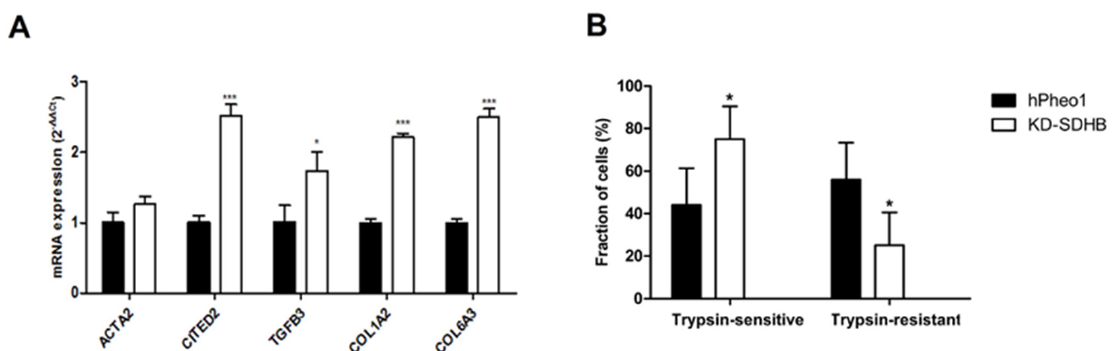
Figure 3. ( A ) Cell adhesion related genes upregulated by KD-SDHB. Relative mRNA expression of ACTA2 , CITED2 , TGFB3 , COL1A2 , and COL6A3 in KD-SDHB hPheo1 cells by RT-qPCR analysis. ( B ) Cell counts for trypsin-sensitive and trypsin-resistant hPheo1 cells presented as percentages of total cell number. Each bar represents the mean ± standard deviation ( n = 3), * ( p < 0.05) and *** ( p < 0.0001), student’s t